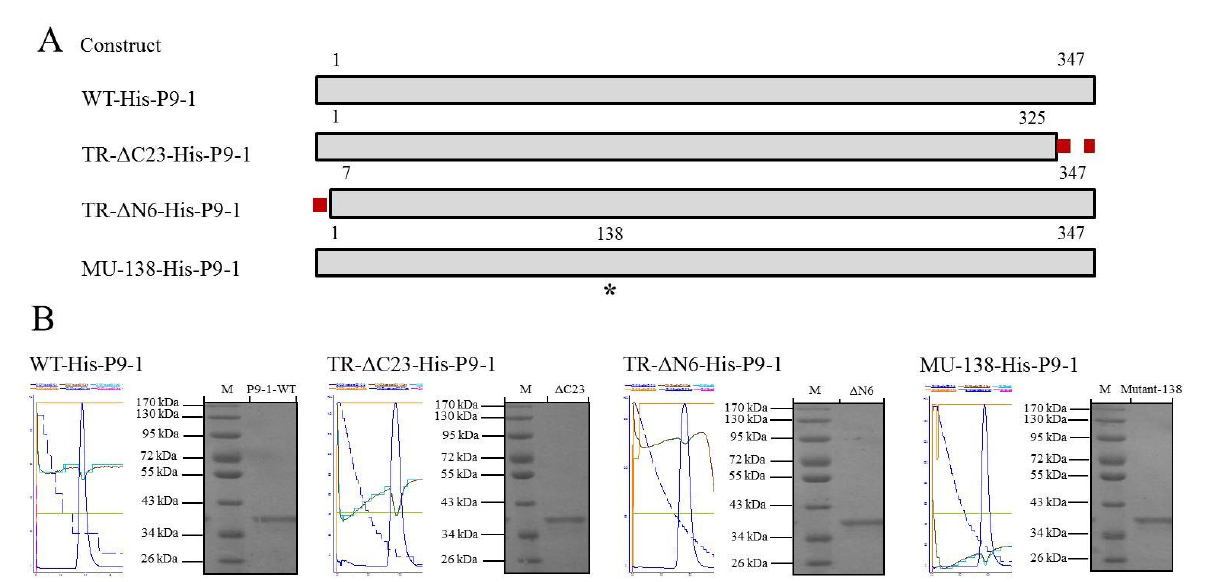
Figure 3. The recombinant plasmid construction and purification of target proteins. ( A ) Schematic illustration of SRBSDV P9-1 protein, which has 347 amino acids. Construct names are indicated in the left blocks to represent the P9-1 region contained in the construct. The discontinuous red lines represent the deleted region. The numbers indicate the relative amino acid positions in P9-1. The asterisk (*) on the 138 residues indicates the site of site-directed mutagenesis; ( B ) expression and purification of the P9-1 protein. The four parts named WT-His-P9-1, TR-ΔC23-His-P9-1, TR-ΔN6-His-P9-1, and MU-138-His-P9-1 represent the desalted proteins. The proteins were separated by 12% SDS–PAGE, with the protein molecular weight standards shown in lane M.